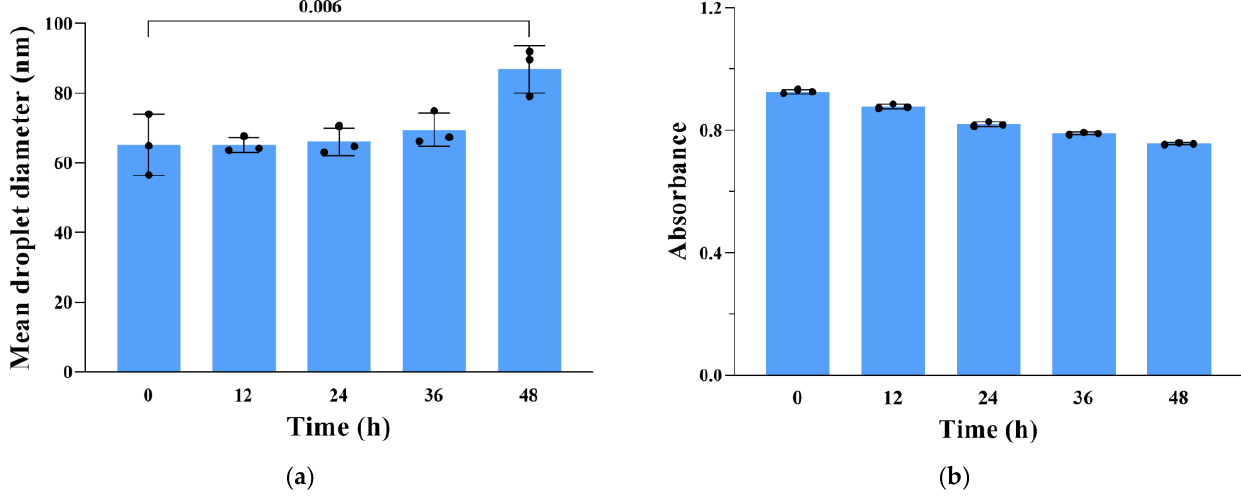
Figure 5. ( a ) Change in CCIPN droplet diameter in pH 7.4 PBS during storage for 48 h at 37 ± 0.5 °C. ( b ) Change in CCIPN absorbance in pH 7.4 PBS during storage for 48 h at 37 ± 0.5 °C. Values are expressed as mean ± SD (n = 3). Each dot represents an independent experiment. The p values vs. indicated groups are presented.